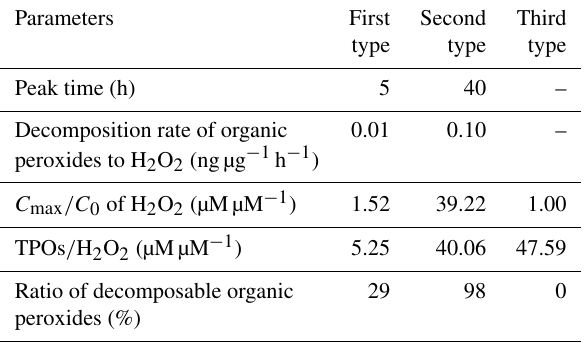
Table 4. Comparison of the H 2 O 2 evolution parameters in the ex- tracted solution among the three